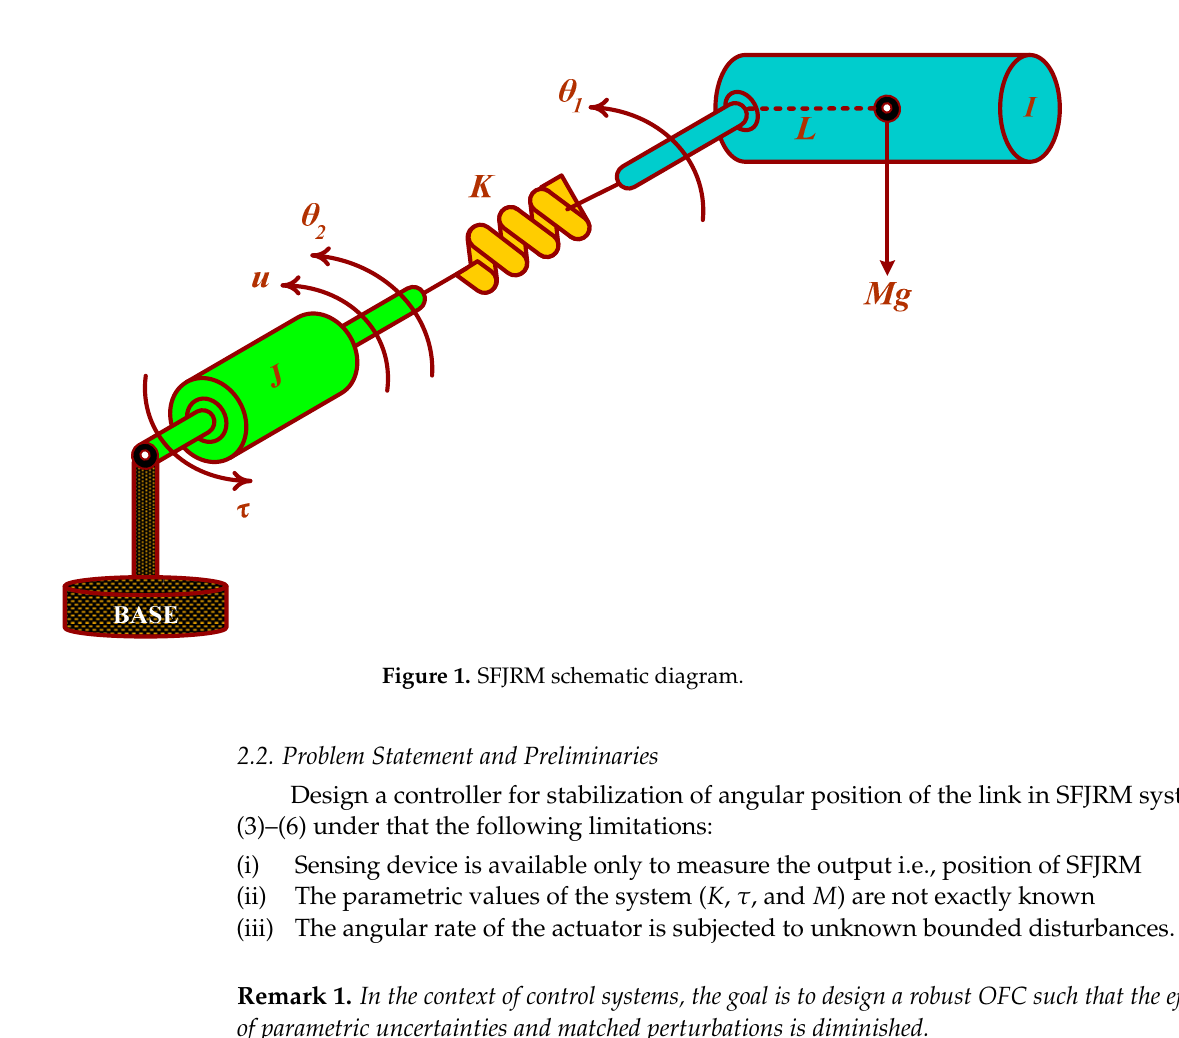
Figure 1. SFJRM schematic diagram.